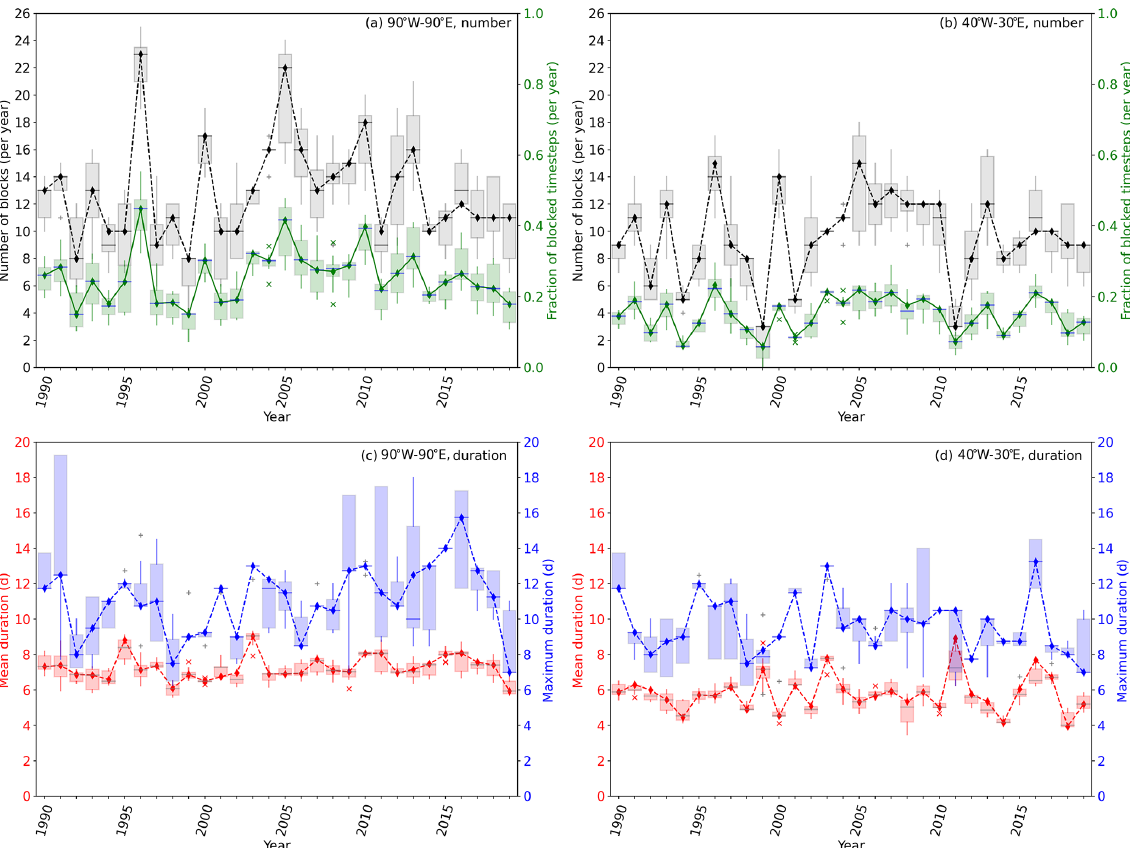
Figure 6. Temporal development of (a, b) blocking number (black) and fraction of annual blocked time steps (green); (c, d) mean (red) and maximum (blue) duration of a blocking event (a, c) for the whole domain (90 ◦ W to 90 ◦ E) and (b, d) for the Euro-Atlantic region (40 ◦ W to 30 ◦ E). Boxes represent the interquartile range of the experiments described in Table 1 to test the uncertainty in the method for different distance criteria between two time steps. The whiskers are 1.5 times the interquartile range, and single points in appropriate colors represent outliers. Note that blocking numbers are given as integers. Experiment E05 is explicitly plotted in colors corresponding to the boxplots by symbols and lines. These lines are just plotted to ease the identification of E05.